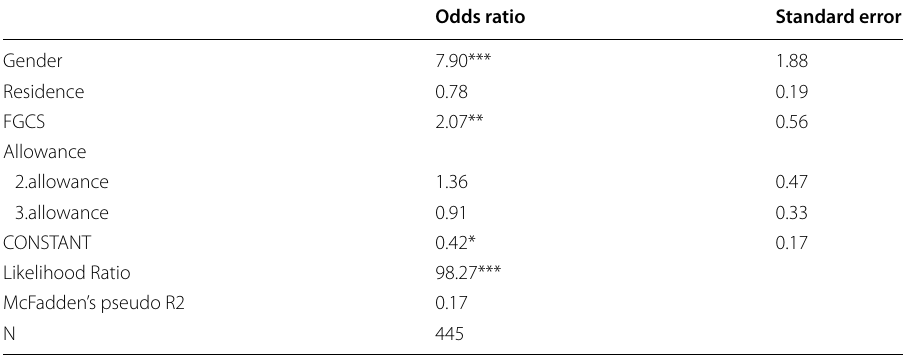
Table 2 Logistic regression analysis on mobile dependency